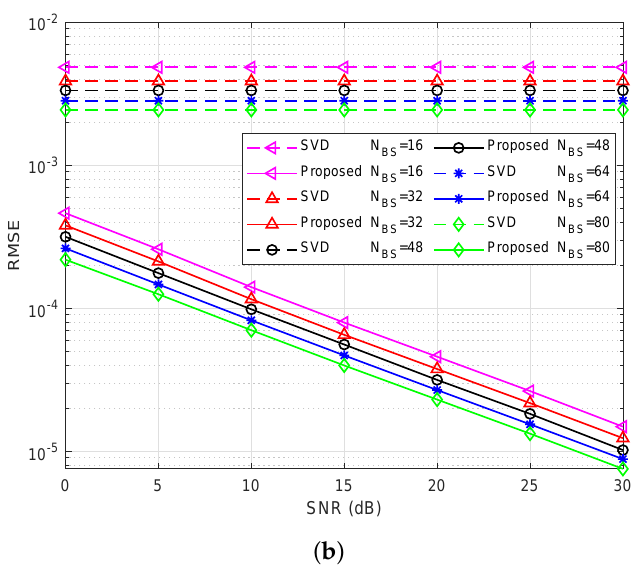
Figure 6. RMSE performance comparison of the proposed and SVD algorithms: ( a ) RMSE versus the number of UEs; ( b ) RMSE versus the number of antennas.